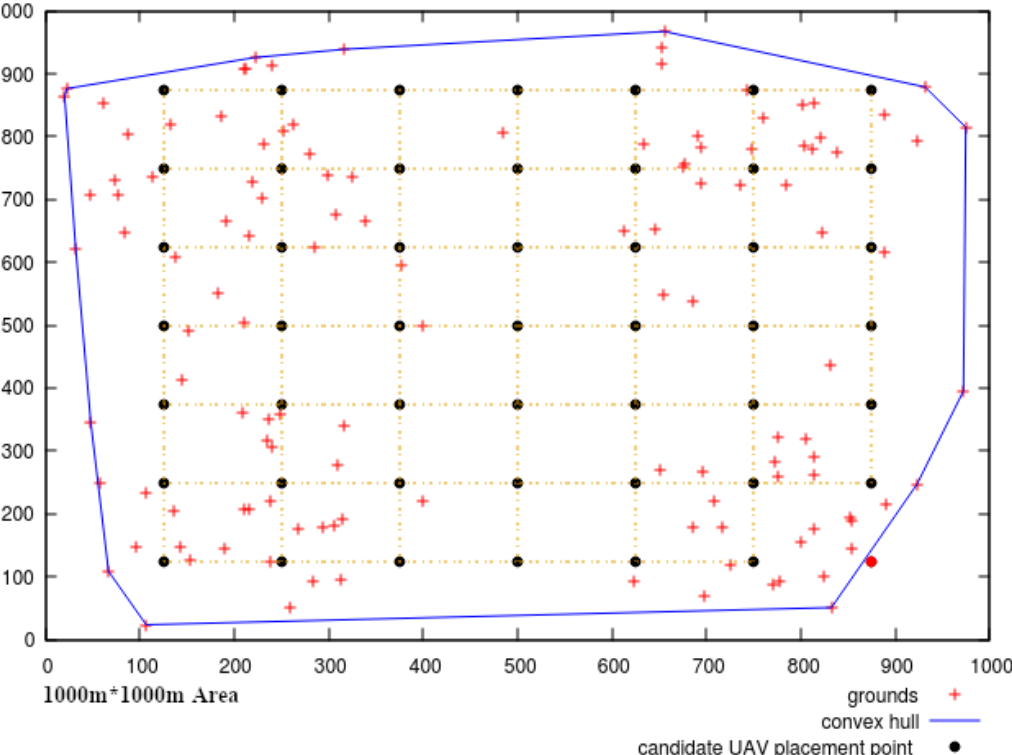
Figure 1. Candidates for aircraft placement as a mesh network within a convex